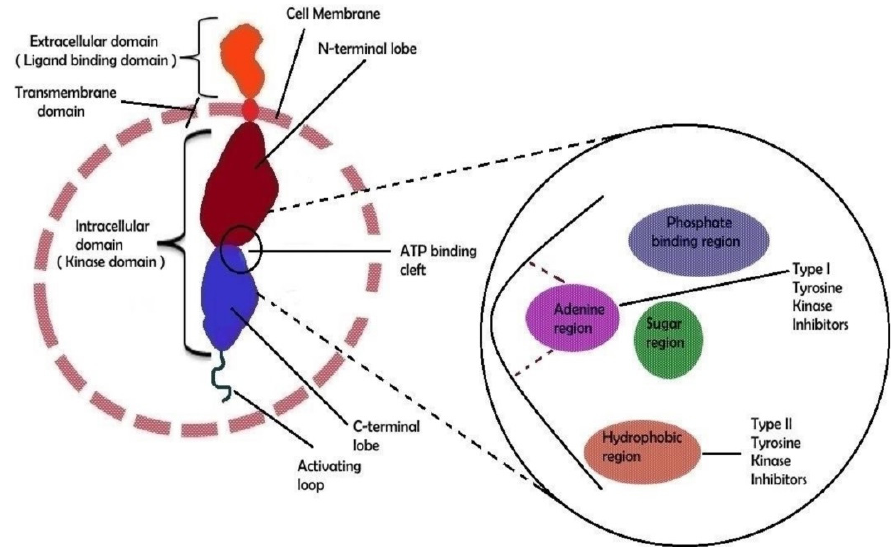
Figure 1. The molecular structural feature of receptor tyrosine kinase (RTK). An RTK’s extracellular domain can bind particular ligands such as growth factors, whereas the intracellular domain is responsible for the kinase’s (auto)phosphorylation. The external and internal domains are separated by the transmembrane region, which is fixed in the cell membrane. The ATP-binding cleft is located between the two lobes of the intracellular domain. A schematic depiction of the ATP binding cleft with its numerous regions is shown on the right side of the image. Type I and type II tyrosine kinase inhibitor binding sites have been shown in a biochemical general structure model. Adapted from [30], Copyright 2021 MDPI.